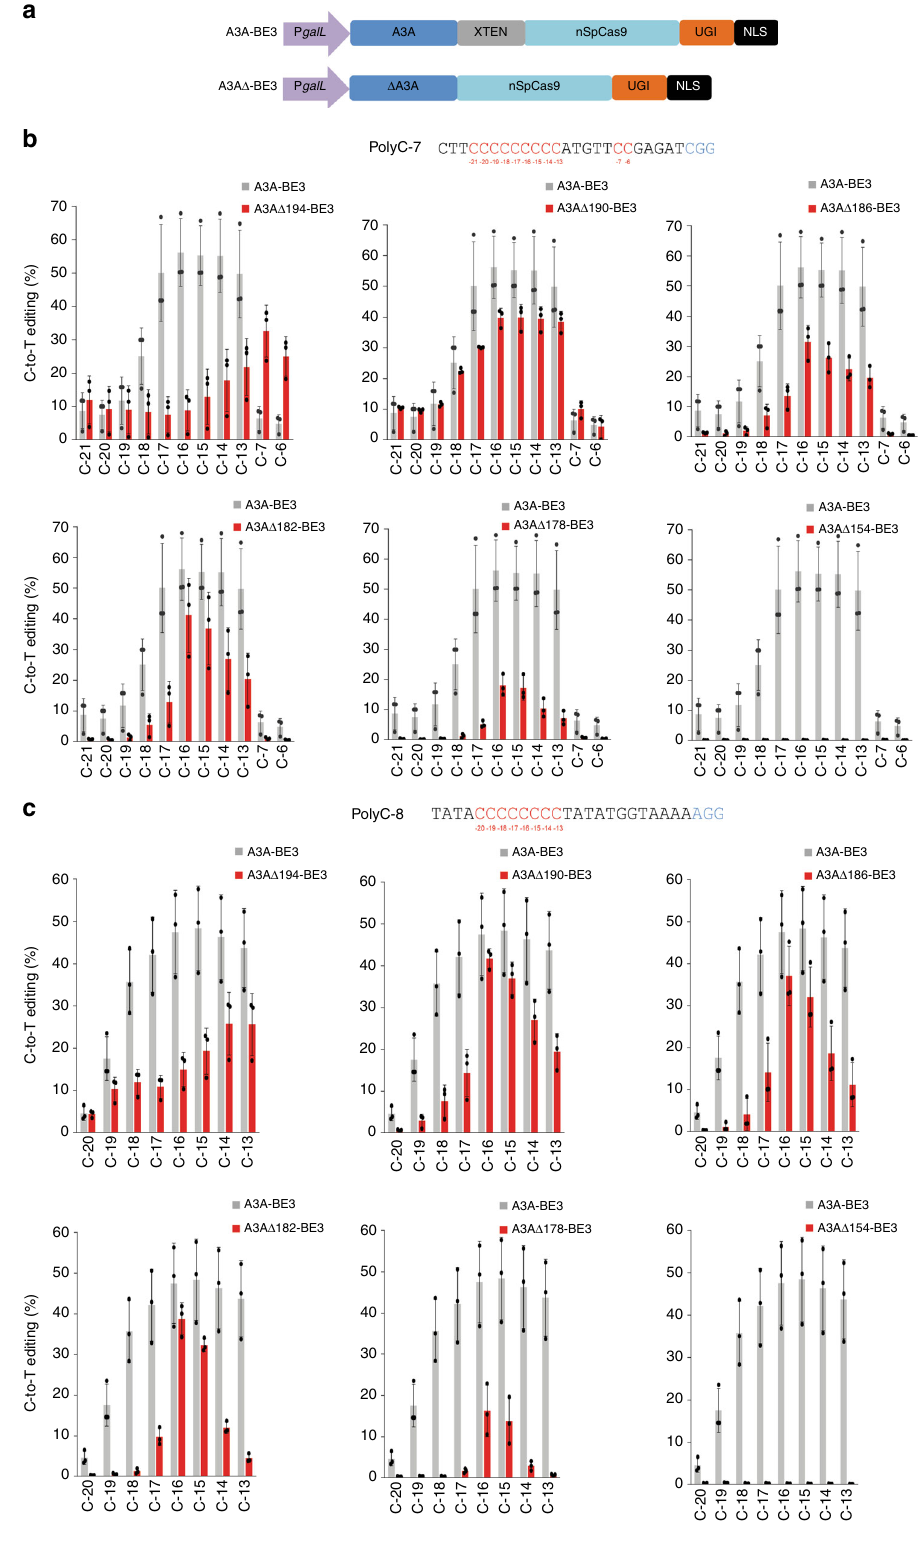
signi fi cantly more speci fi c in that A3A Δ 182-BE3 preferentially edits position C − 15 or C − 16 (Fig. 2b; Supplementary Table 2). When tested on target sequence polyC-8, the truncated editors A3A Δ 190-BE3, A3A Δ 186-BE3 and A3A Δ 182-BE3 displayed improved speci fi city. For example, A3A Δ 182-BE3 exhibits a strong preference for positions C − 15 and C − 16 , while showing